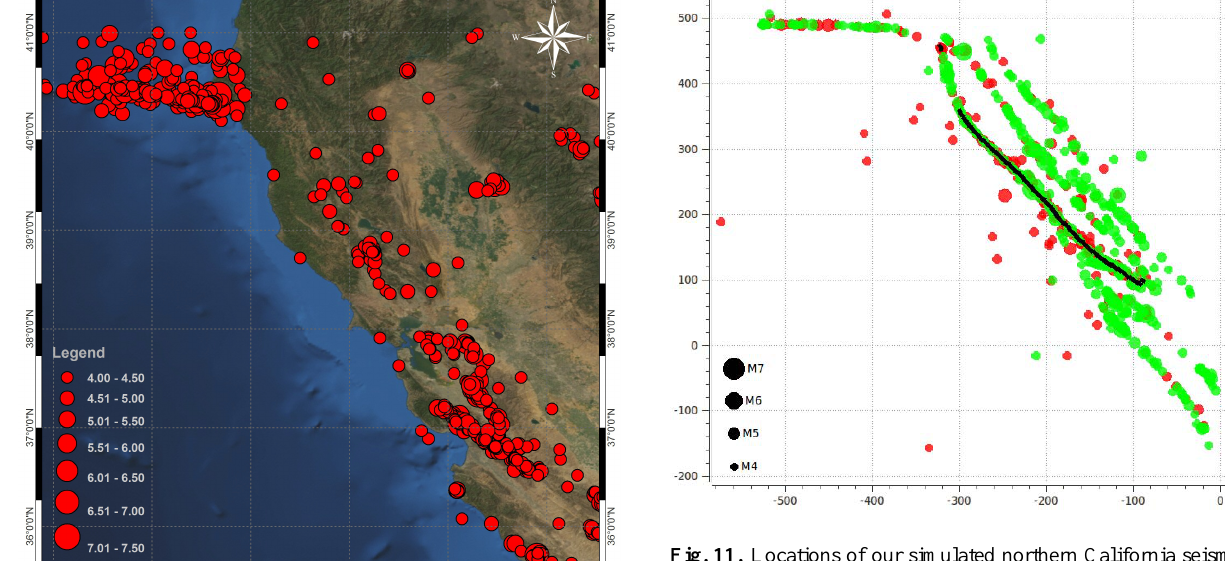
Fig. 11. Locations of our simulated northern California seismicity with M ≥ 4 during a 40yr period. The period selected included a M = 7.79 VC earthquake on the northern San Andreas Fault. The rupture during this simulated earthquake is shown by the solid black line. Aftershocks during the 40yr are shown in red and background seismicity in